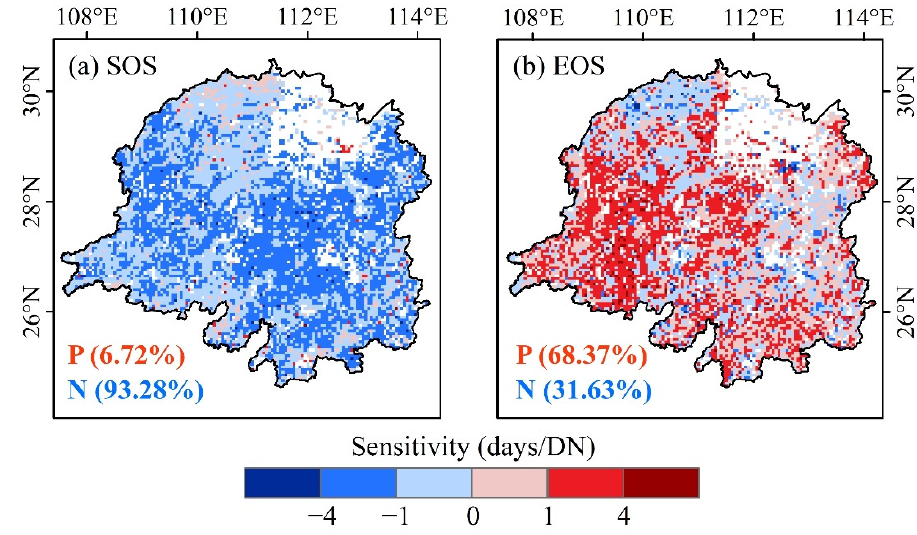
Figure 6. Spatial distribution of sensitivity of vegetation phenology to light intensity in Dongting Lake basin. ( a ) start of the growing season (SOS) and ( b ) end of the growing season (EOS). The phenology of different vegetation types was significantly affected by urbanization.